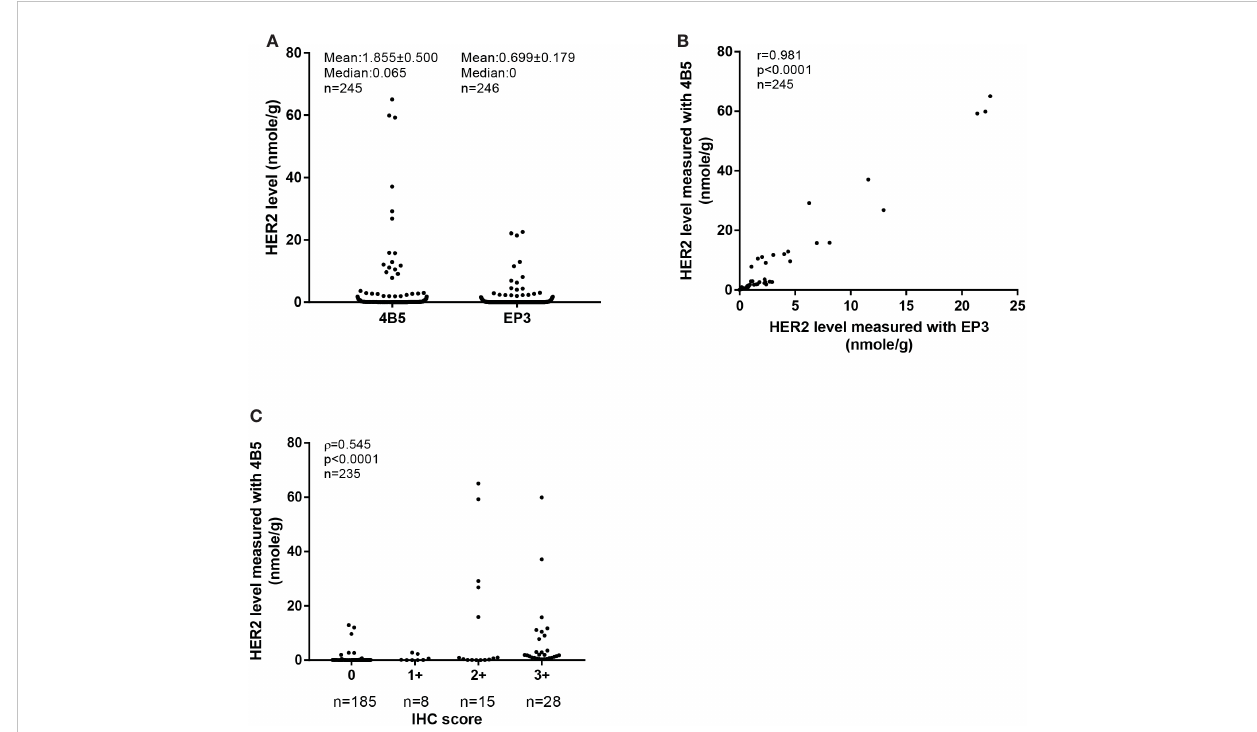
FIGURE 3 Absolutely quantitative analysis of Her2 expressions in cohort 2. (A) The distribution of HER2 levels measured with the QDB method using 4B5 and EP3 antibodies respectively in cohort 2. The results were expressed as mean ± SEM. (B) Correlation analysis of the Her2 levels in cohort 2 measured with the QDB method using 4B5 and EP3 antibodies, respectively. Pearson ’ s correlation analysis was performed with r = 0.981, p < 0.0001. (C) Correlation of HER2 levels measured with QDB using the 4B5 antibody with those from IHC analysis. The results were analyzed using Spearman ’ s correlation analysis with r = 0.545, p < 0.0001.